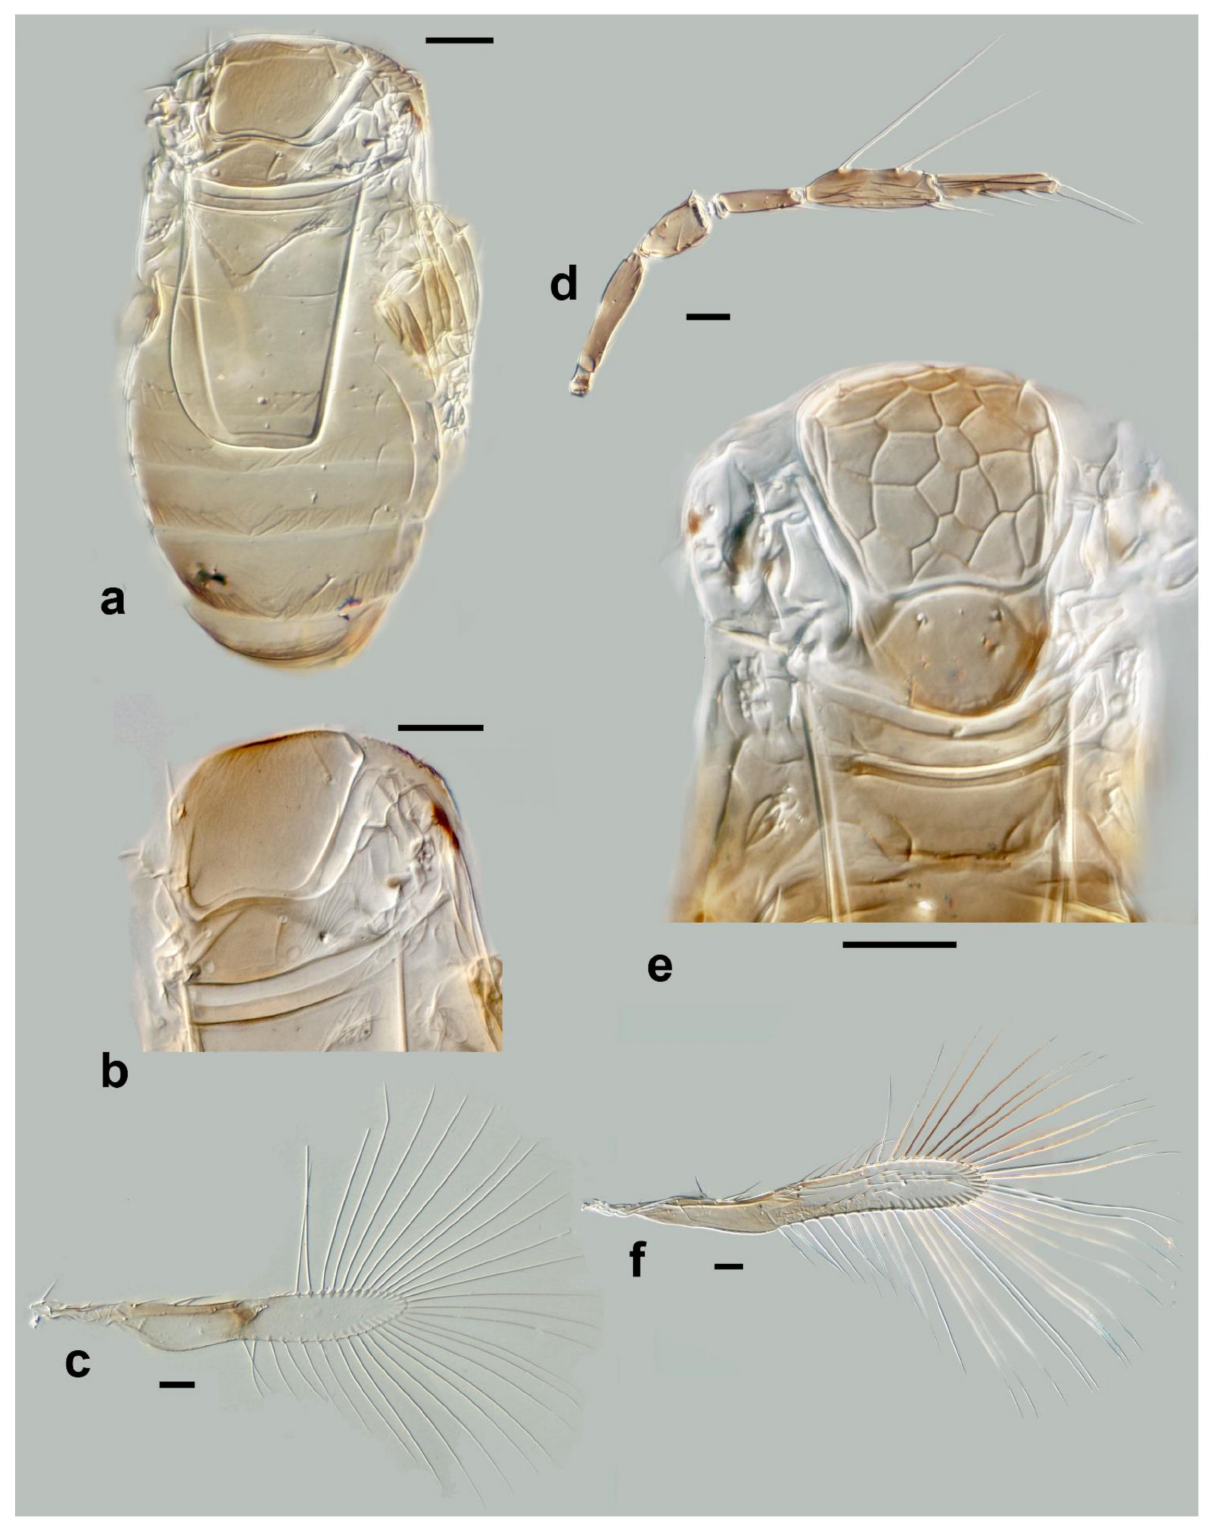
Figure 13. Photographs of Megaphragma species: ( a ) M. chienleei , male dorsal meso- and metasoma (Paratype); ( b ) M. chienleei , male dorsal mesosoma (Paratype); ( c ) M. chienleei , male fore wing (Paratype); ( d ) M. cockerilli , female antenna (Holotype); ( e ) M. cockerilli , female dorsal mesosoma (Holotype); ( f ) M. cockerilli , female fore wing (Holotype). Scale bars 20 µ